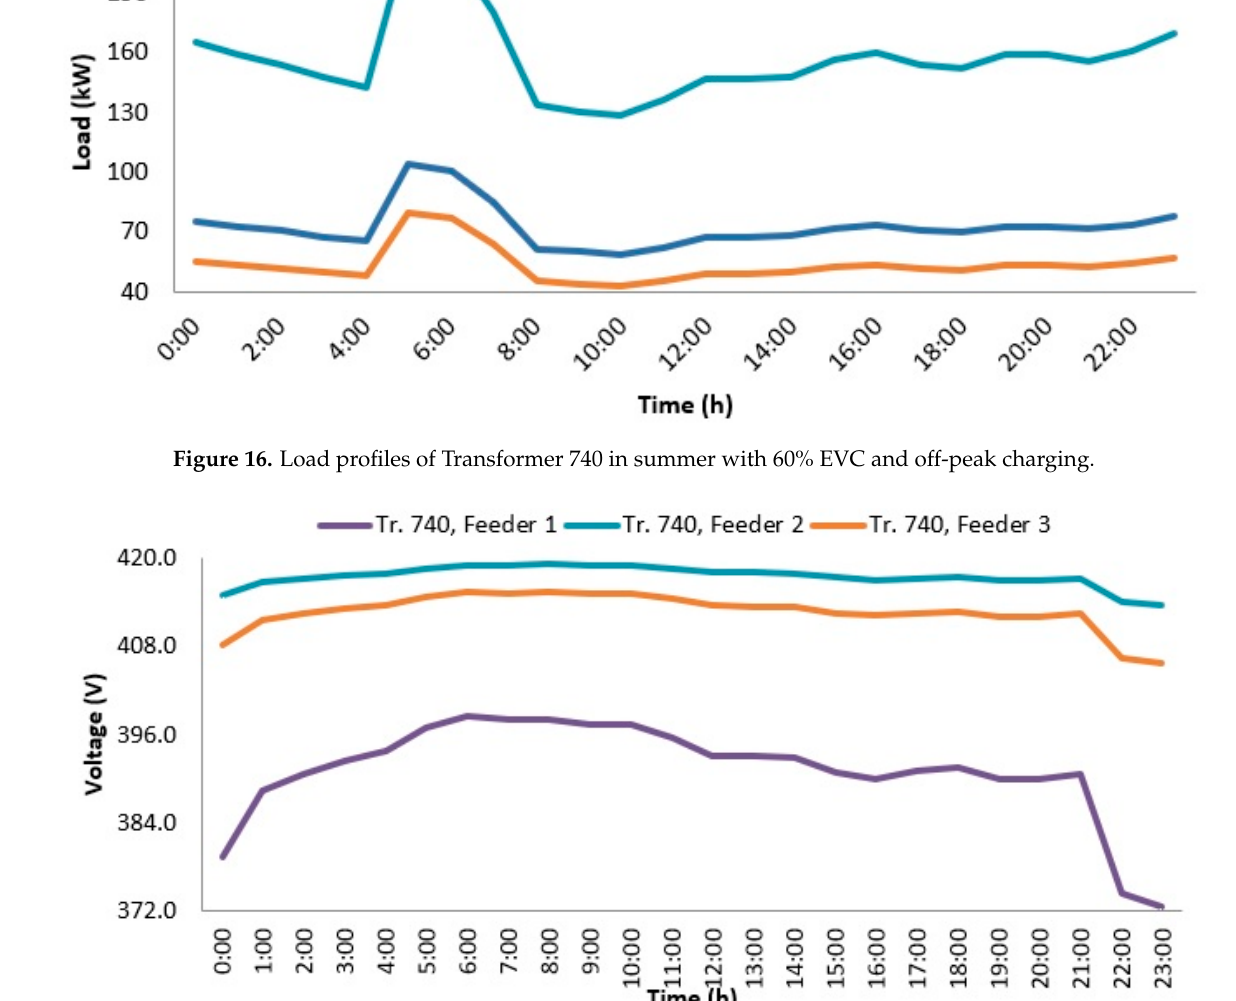
Figure 17. Voltage profiles at the end of Transformer 740 in summer with 60% EVC and overnight charging.